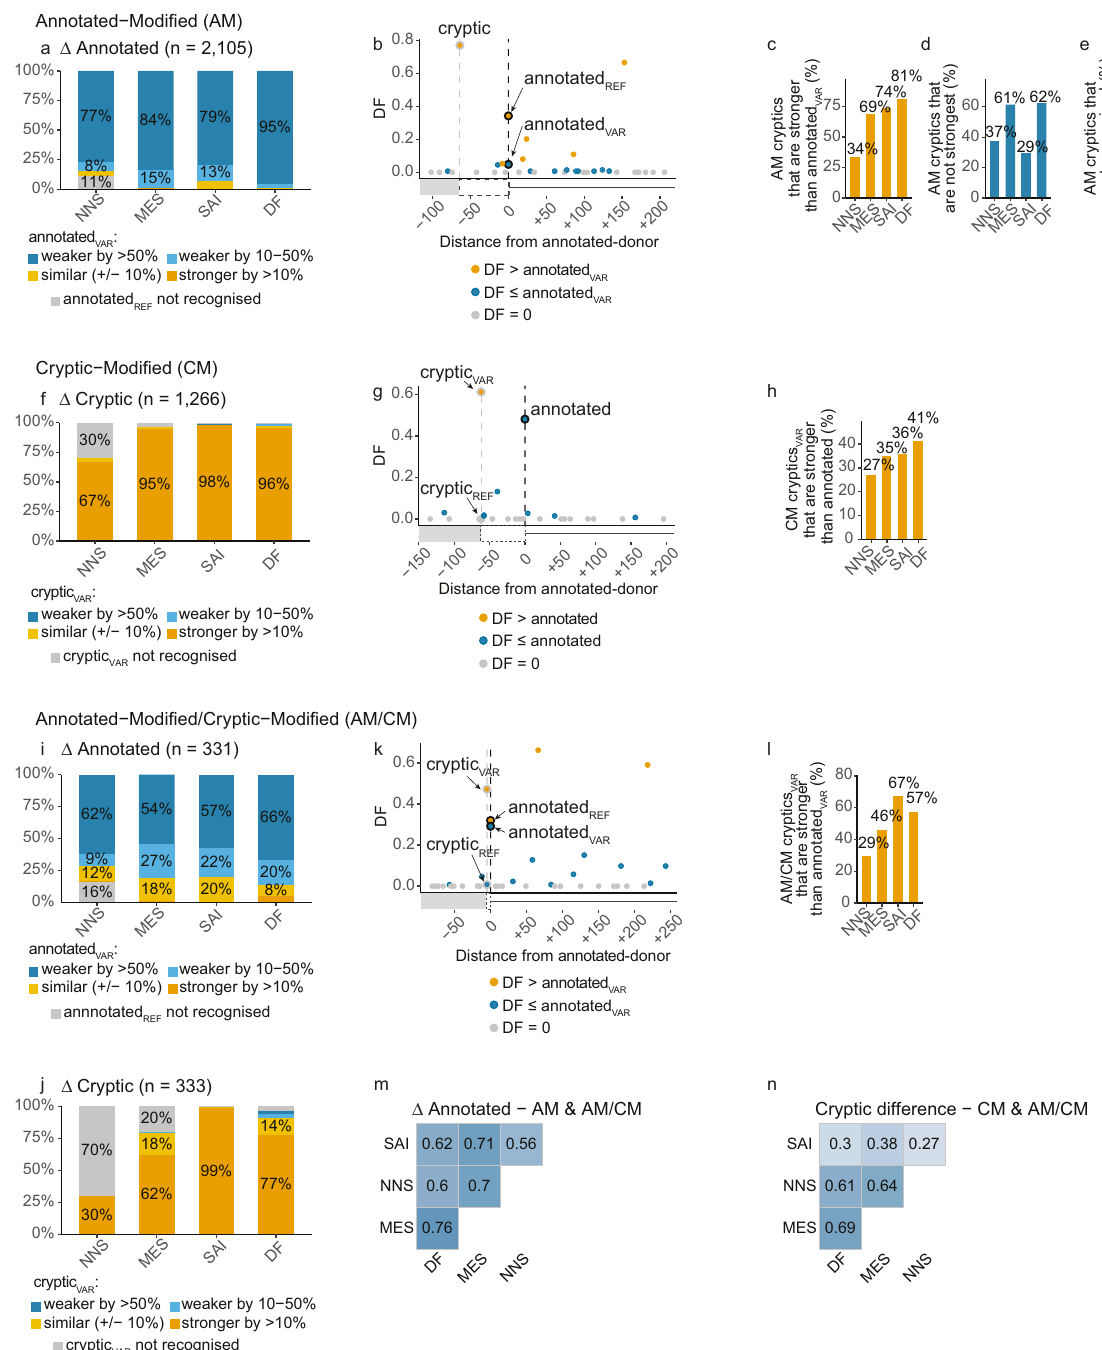
Fig. 3 Cryptic donor activation is in fl uenced by relative strength. a – e Assessment of algorithmic scores of splice-site strength for AM-variants. NNS NNSplice, MES MaxEntScan, SAI SpliceAI, DF Donor Frequency. Categories such as weaker by >50% are assigned based on how the score has been impacted by the variant (i.e., more than halved). a Proportion of variants with annotated-donor Δ scores (Annotated VAR /Annotated REF ) in each of the categories shown in the fi gure key. Most AM-variants weaken the annotated-donor by >50% (dark blue). See supplementary Fig. 2 for full plots. b Example variant showing the Donor Frequency (DF) scores (see supplementary Fig. 1) for the cryptic-donor (DF = 0.77), versus the reference (REF = 0.34) and variant (VAR = 0.05) annotated-donor, as well as surrounding decoys not used. Vertical dotted lines indicate position of annotated- and cryptic-donors. Donors coloured according to the fi gure key. c Percent of cryptic-donors stronger than the annotated VAR . d Percent of cryptic-donors that are not the strongest donor splice-site within 250 nt. e Percent of AM-variant activated cryptic-donors that are not recognised by each algorithm (i.e., score of 0). f – h Strength measures for CM-variants. f Proportion of variants with cryptic-donor Δ scores (Cryptic VAR /Cryptic REF ) in each of the categories shown in legend. Most CM-variants strengthen the cryptic-donor by >10% (dark yellow). See supplementary Fig. 2 for full plots. g As in b . h As in c . i , j Strength measures for AM/CM-variants. i As in a . j As in f . k As in b . l As in c . m , n Pearson correlation of strength measures. m Δ Annotated (VAR/REF) for AM & AM/CM-variants (all variants which affect the annotated-donor). n Cryptic difference (VAR – REF) for CM & AM/CM-variants (all variants which affect the